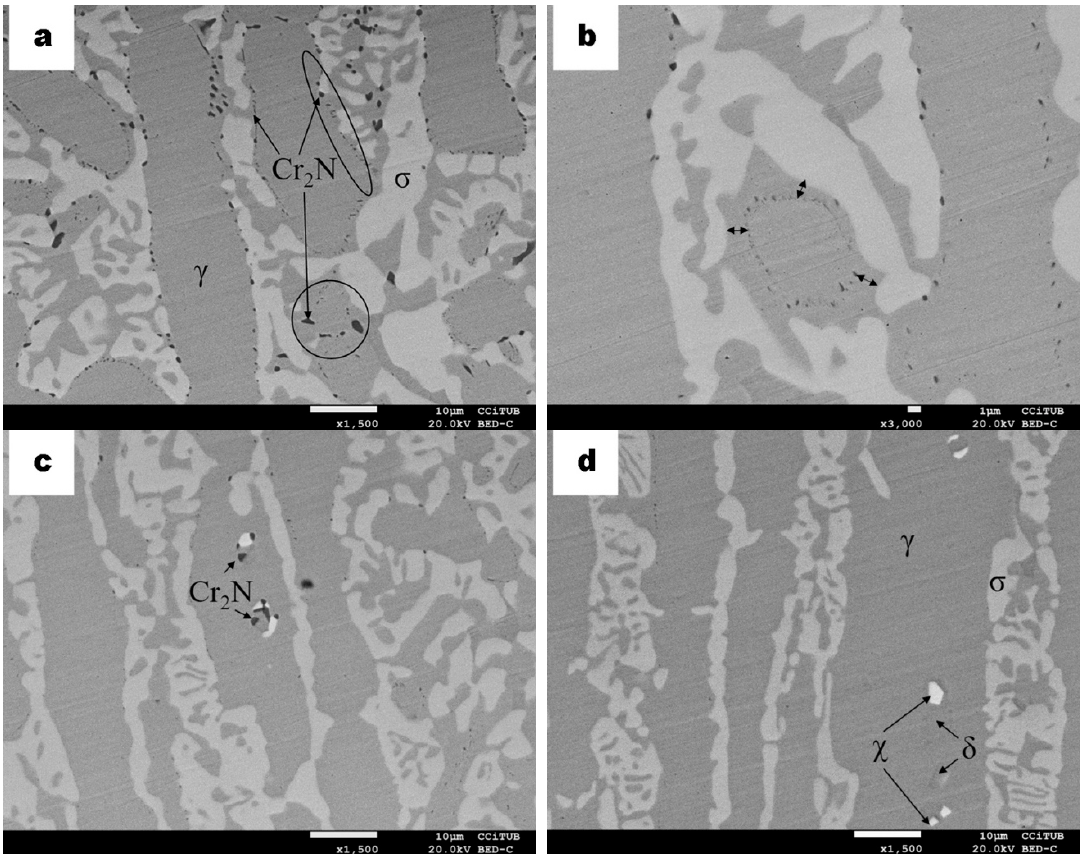
Figure 7. BSE micrographs of SDSS specimen cross-sections after isothermal aging for 10 h at 925 °C. ( a ) Microstructure of the sample near the surface, indicating austenite ( γ ), ferrite ( δ ), sigma ( σ ) and chromium nitrides (dark spots). ( b ) Higher magnification of a zone near the surface indicating with arrows the displacement of the nitrides from the γ / σ boundary, forming a circle. ( c , d ) show the microstructure away from the surface of the sample indicating chi-phase nucleation.